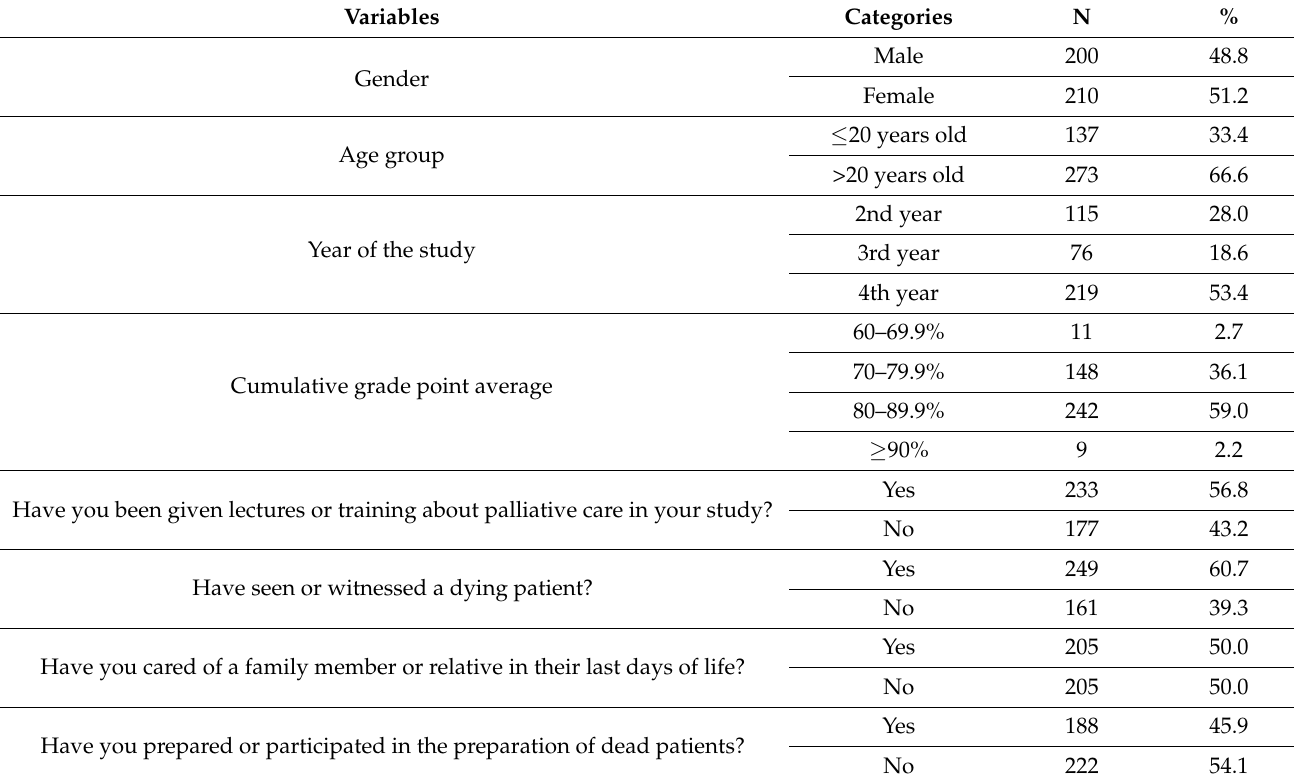
Table 1. Socio-demographic characteristics of nursing students (n = 410).